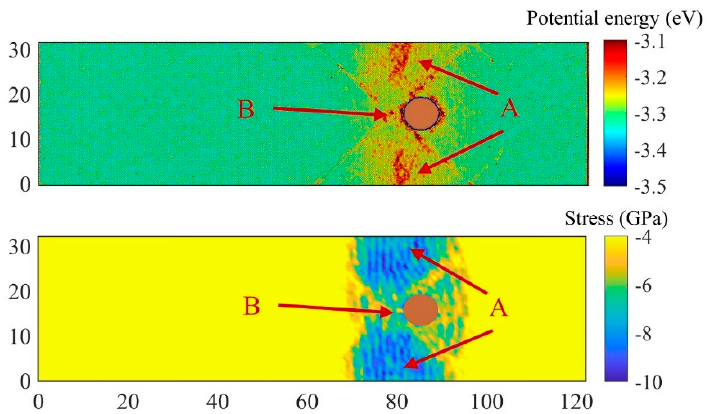
Figure 8. Microstructure evolutions of Al–Cu during spallation process. The Al atoms are color-coded by CSP. ( a ) u p = 0.8 km/s; ( b ) u p = 1.0 km/s; ( c ) u p = 1.5 km/s.